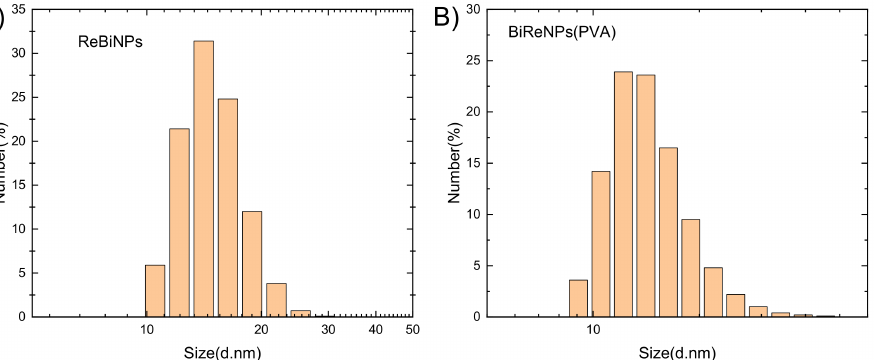
Figure 7. DLS analysis results in the form of particle size histograms according to distribution for ( A ) a solution of rhenium–bismuth nanoparticles synthesized without a stabilizer (PVA). ( B ) A solution of rhenium–bismuth nanoparticles synthesized in the presence of a stabilizer. Both rhenium and bismuth concentrations were 1 × 10 − 4 mol/dm 3 .